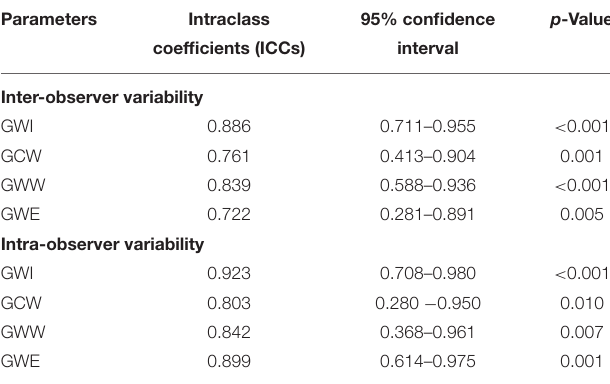
TABLE 3 | Intra- and inter-observer reproducibility of myocardial work